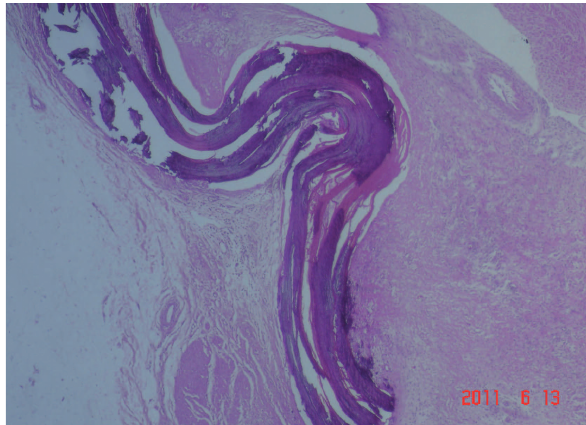
Fig. 4 - Aspecto microscópico das próteses preservadas em L-